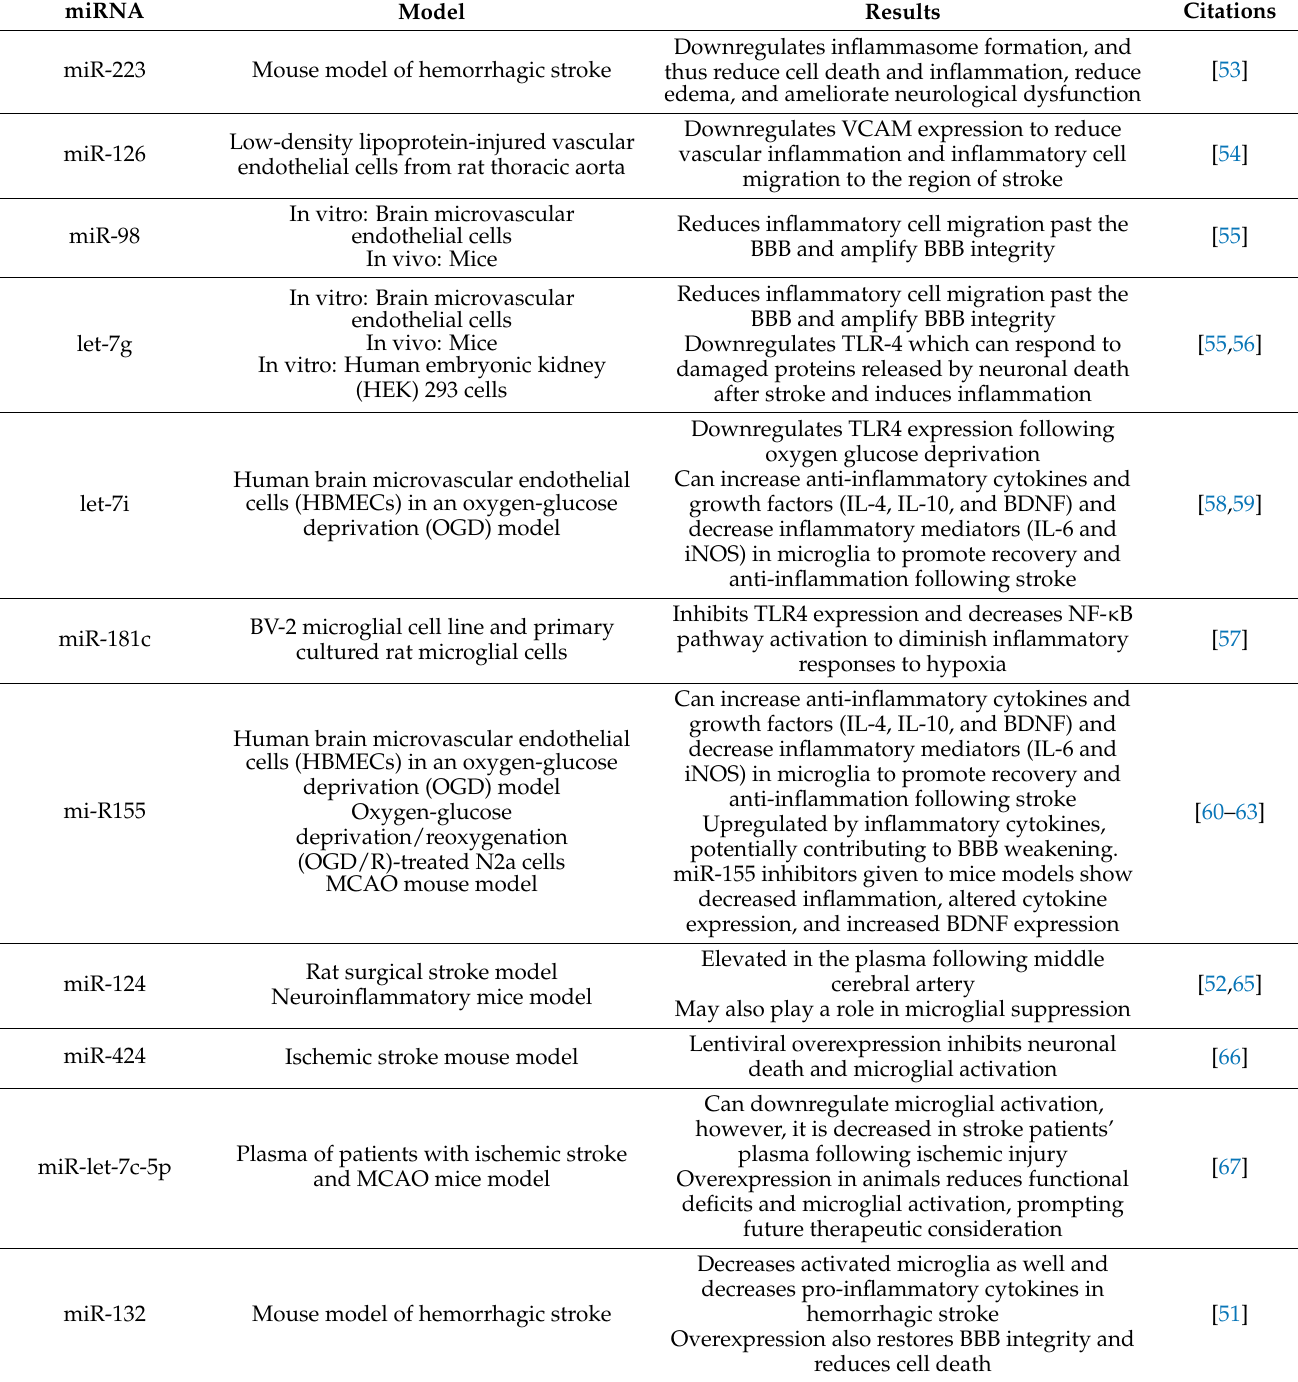
Table 1. miRNAs involved in stroke inflammatory responses. This table describes the various roles of microRNA in modulating inflammatory responses after